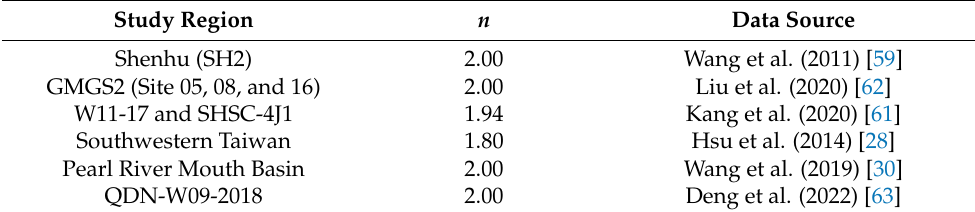
Table 1. Archie’s empirical saturation index in the